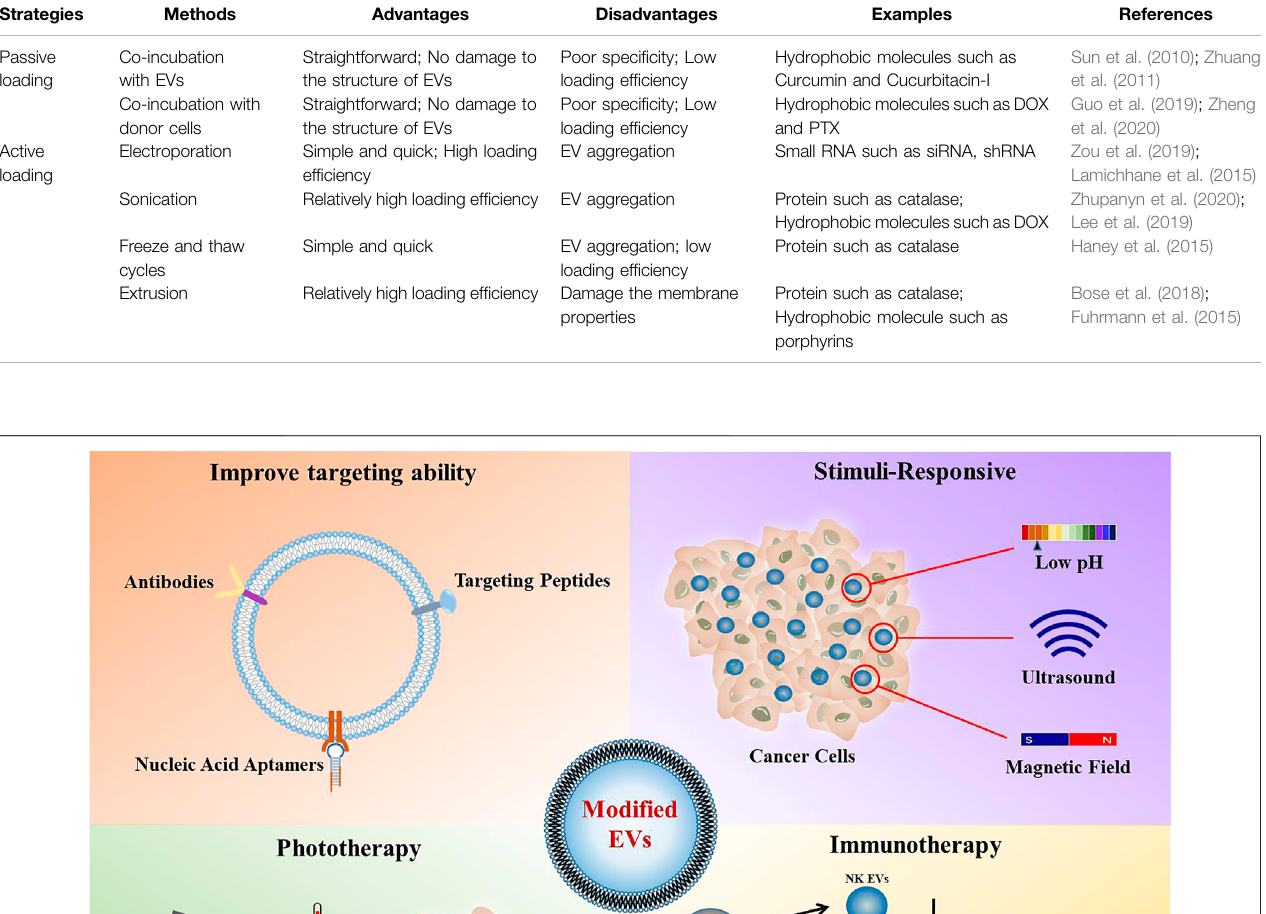
TABLE 1 | Cargo loading strategies for EV modi fi cation.